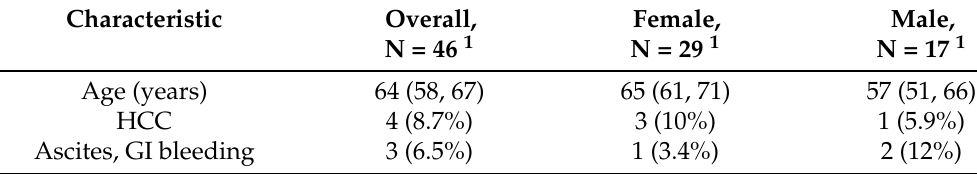
Table 1. Descriptive statistics of the patients. The adverse liver events were HCC (hepatocellular carcinoma), ascites and/or upper GI (gastrointestinal)